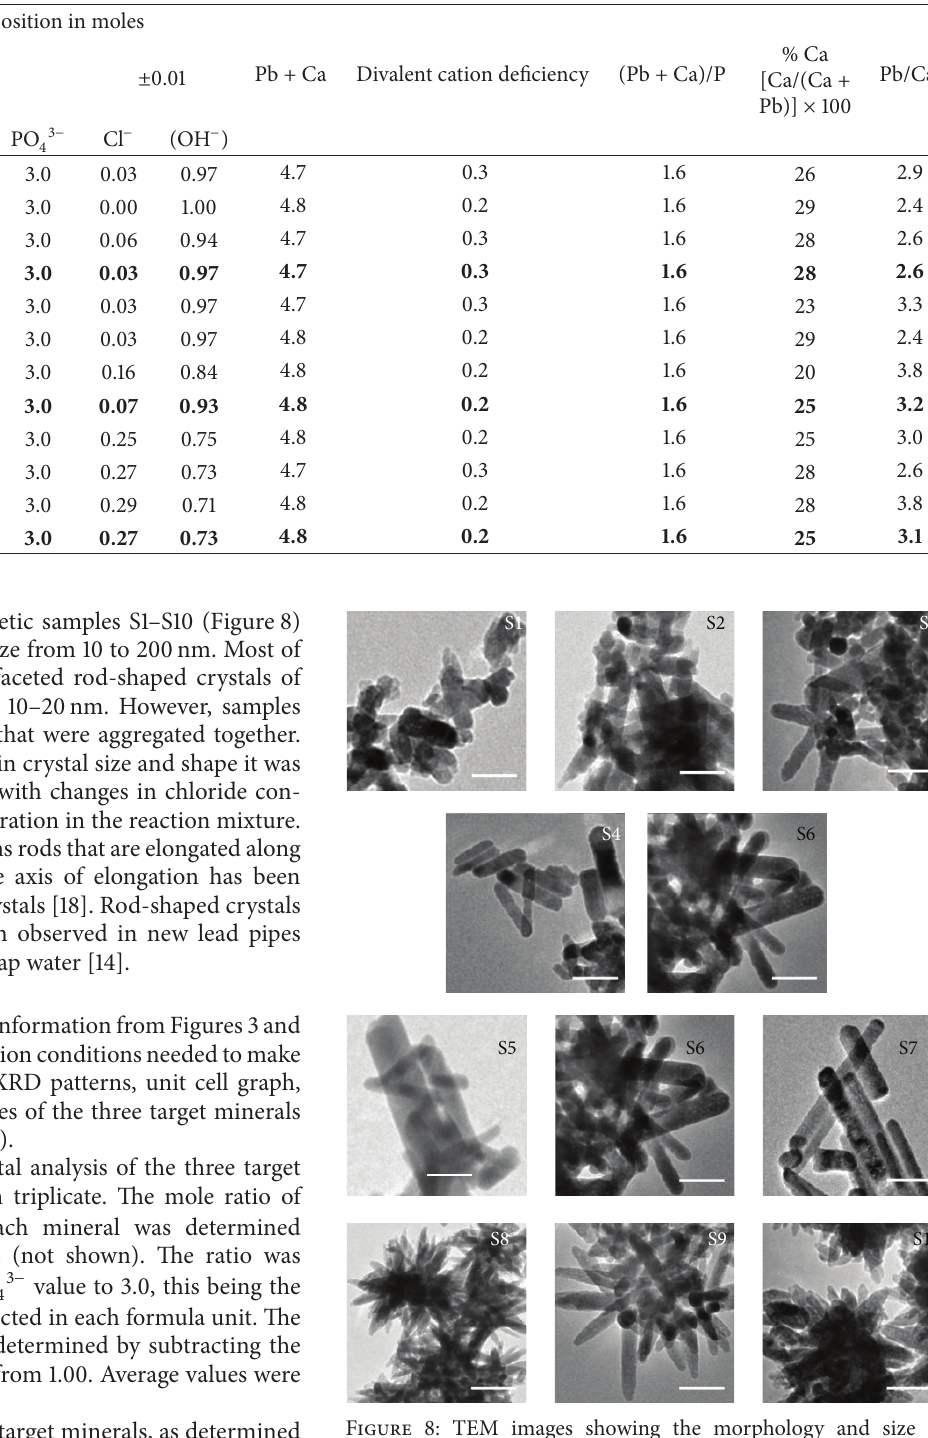
Table 2: Composition of the target minerals determined from elemental analysis.